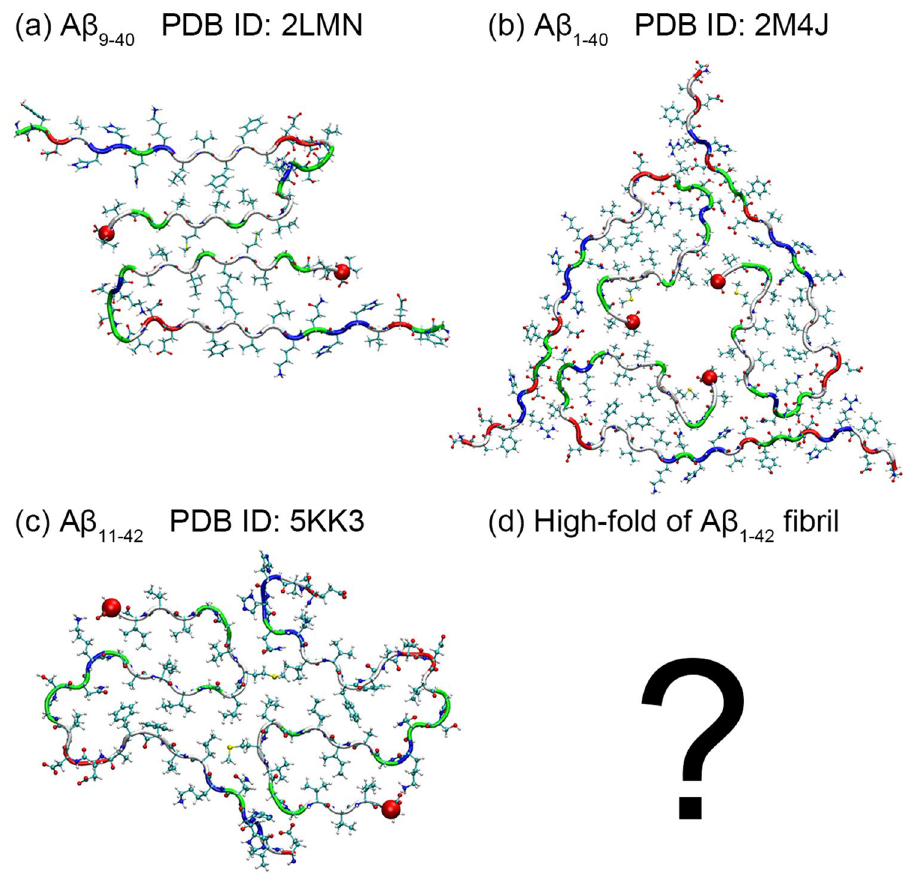
Figure 2. Polymorphism in A β fibrils. Top row: Two-fold ( a ) and Three-fold ( b ) U-shaped A β 40 fibril chains; bottom row: two-fold S-shaped A β 42 fibril chains ( c ); higher-fold fibril arrangements have not yet been observed